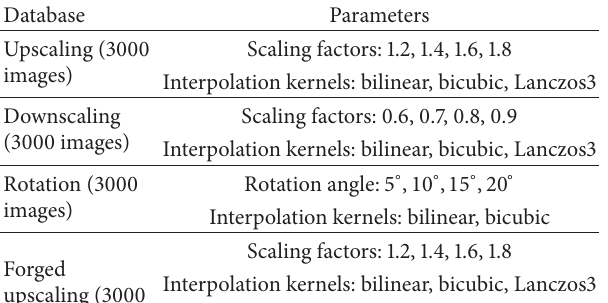
Table 1: Parameters used to create resampled image database. Database